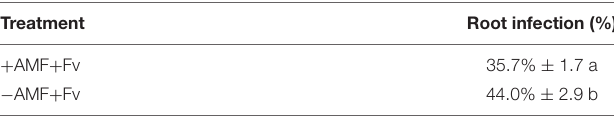
TABLE 2 | Percentage of root infection in presence ( + AMF + Fv) or absence ( − AMF + Fv) of the mycorrhizal fungi.